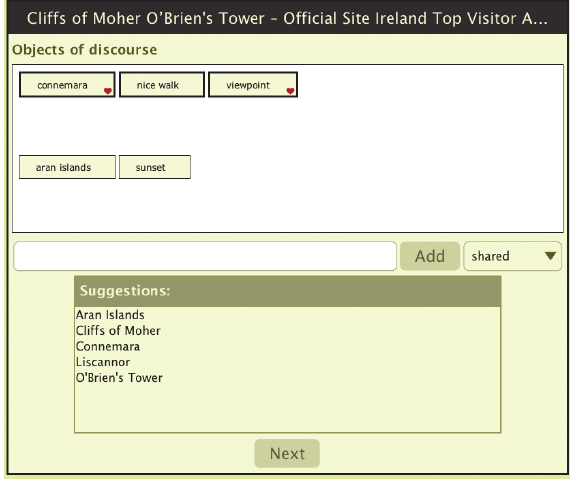
Figure 1: The property window of a table